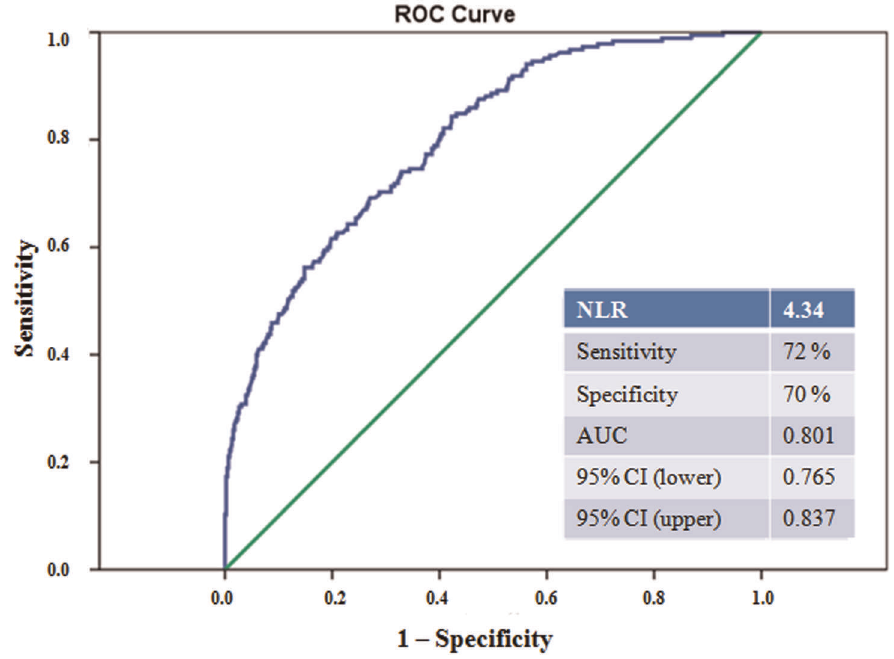
Figure 2 - Receiver operating characteristic (ROC) curve analysis of the use of neutrophil-to-lymphocyte ratio (NLR) values for predicting persistent coronary no-flow after wire insertion (AWI) (AUC 0.801, 95% CI